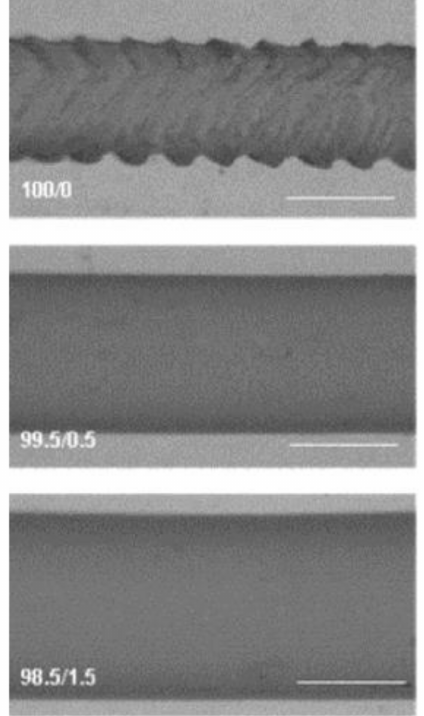
Figure 4. Microgaphs of metallocene polyethylenes and ultra-high molecular weight polyethylene blends of extrudates obtained at 169 ◦ C. Adequate blend composition brings about smooth extrudates (bottom). The line in the picture corresponds to 1 mm [18] Reprinted with permission from [18]. Copyright 2004 American Chemical